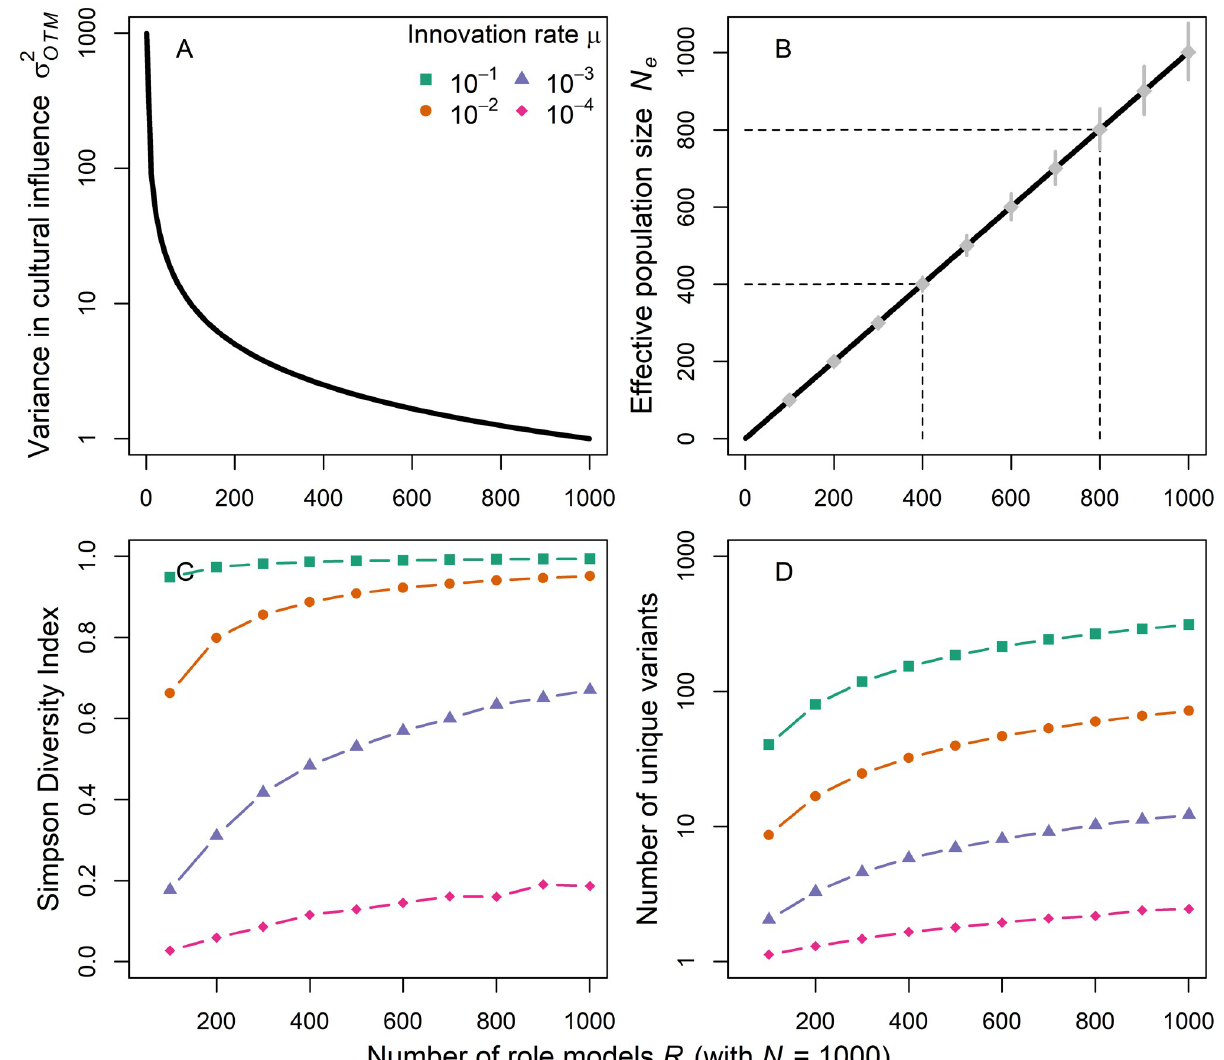
Fig 2. One-to-many transmission. Variance in cultural influence ( s 2 ; 2A), effective population size ( N e ; 2B), mean Simpson diversity (2C) and mean OTM number of unique cultural variants (on log scale; 2D) for different numbers of cultural role models R (with census population size N = 1000). Analytical results were confirmed by stochastic simulations. Grey diamonds in plot 2B show means and 90% prediction intervals for 1000 independent simulations (with μ = 10 − 4